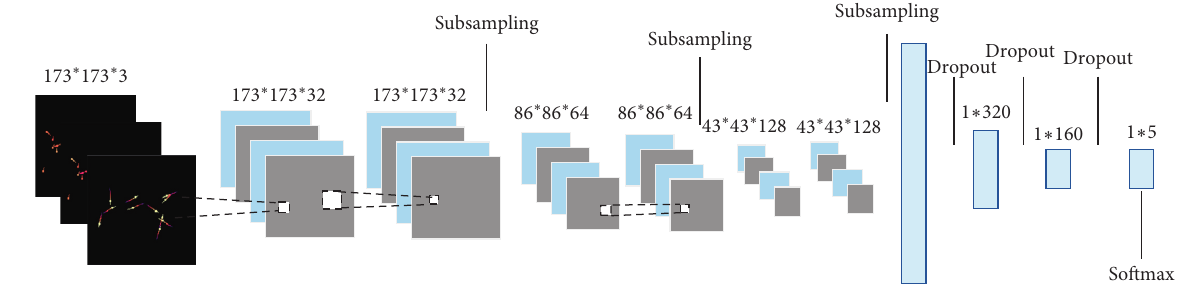
Figure 4: Network architecture of our convolutional neural